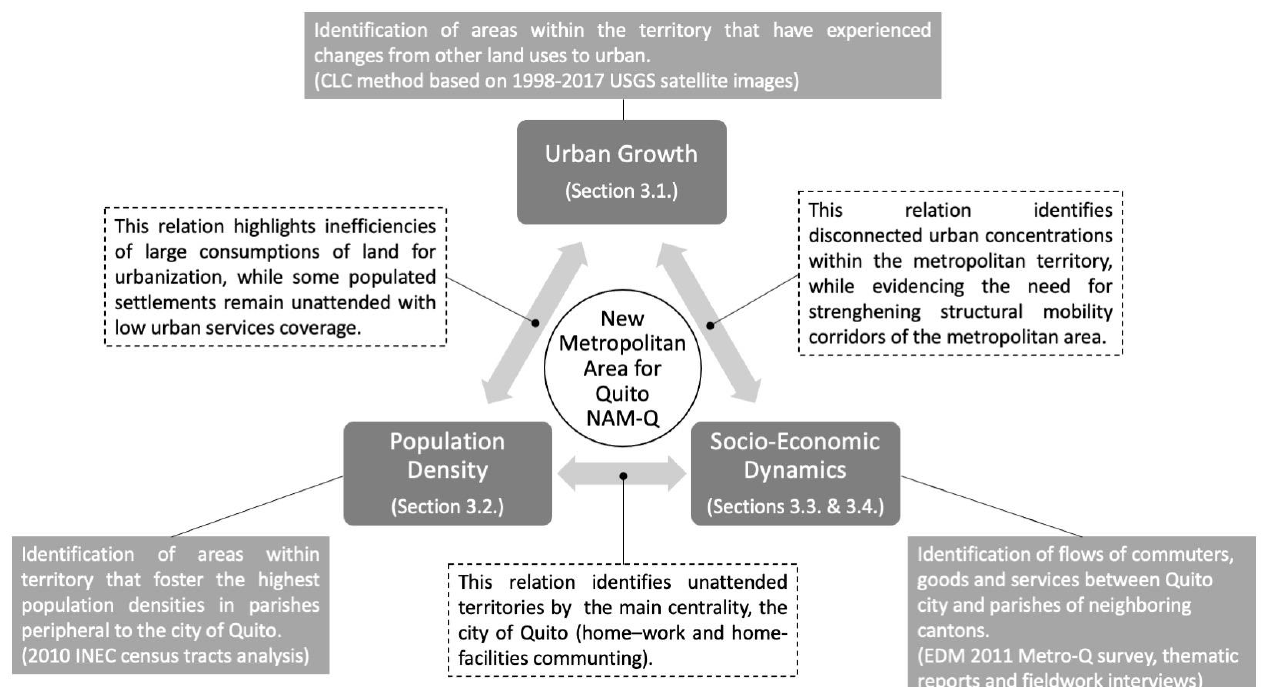
Figure 3. Methodological scheme to identify a New Metropolitan Area for Quito.